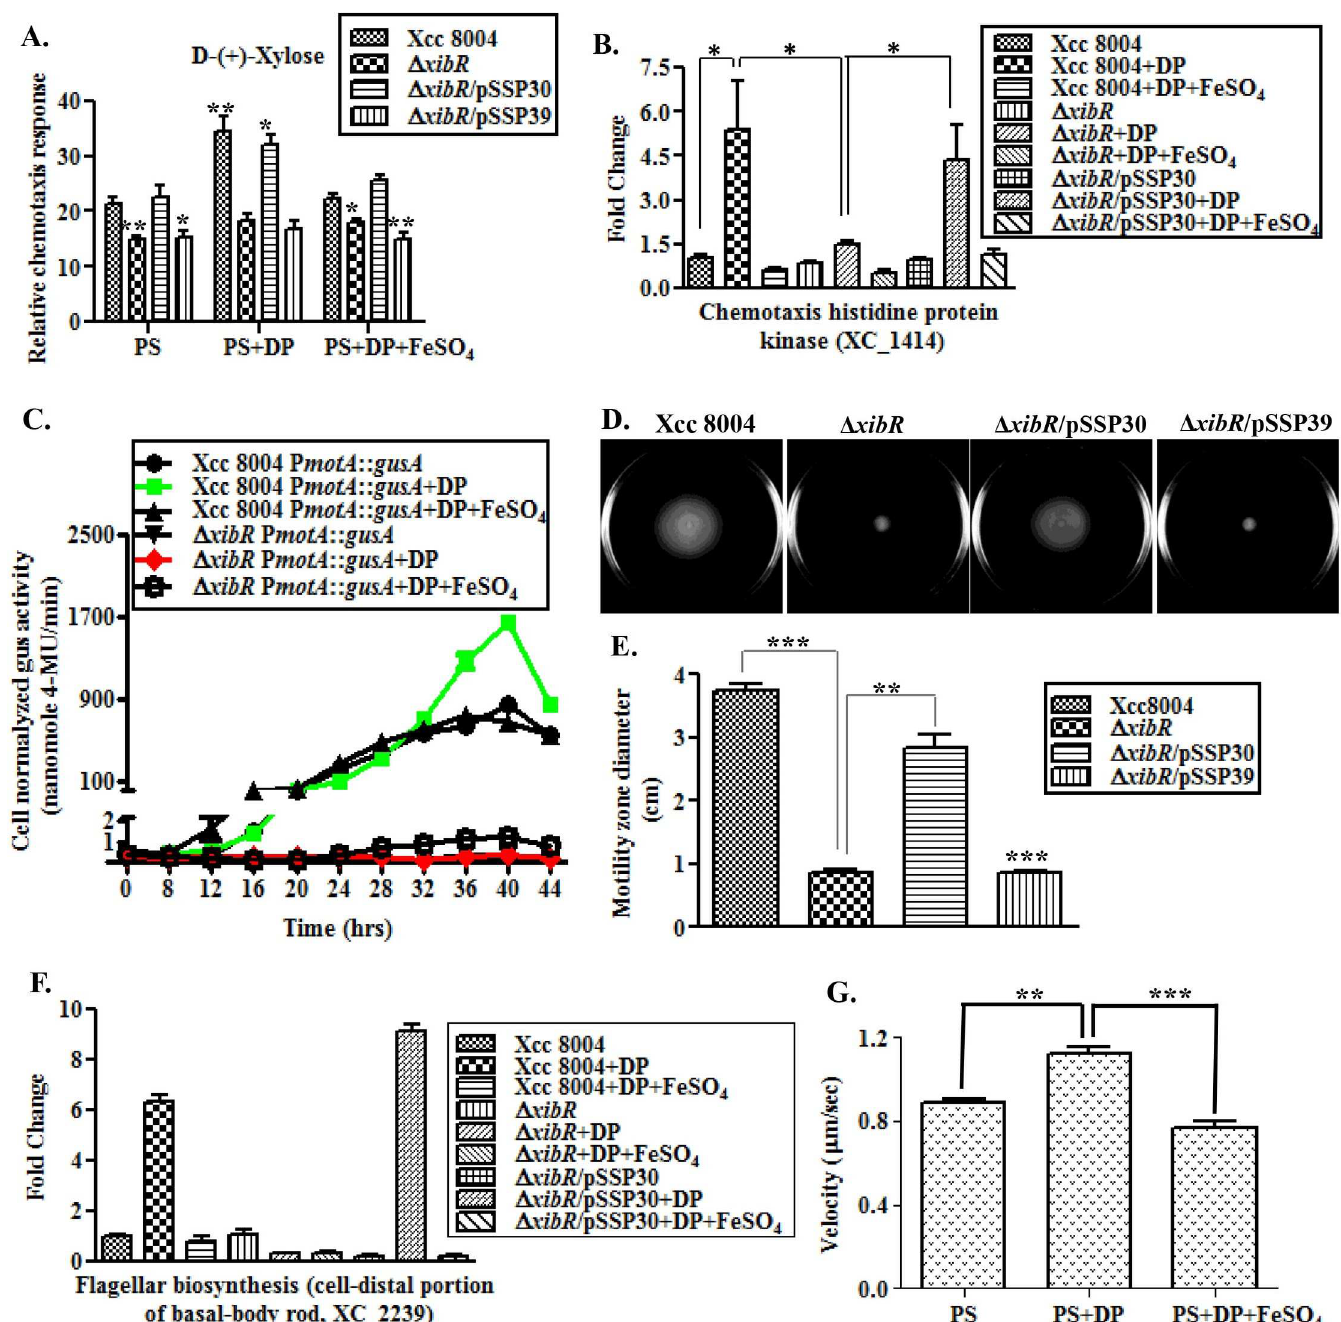
Fig 5. Chemotaxis and motility are regulated by xibR and induced under iron limitation. (A) Quantitative chemotaxiscapillaryassay in responseto D- (+)-Xylose with different Xcc strains grown under PS, PS + 100 μ M DP and PS + 100 μ M DP + 100 μ M FeSO 4 . Cells were incubatedat 28˚C with capillaries containing D-(+)-Xylose (1.2 mM) and PBS. Relativechemotaxisresponse was determined by migratedbacterialcells in capillarycontaining D-(+)-Xylose over the migrated bacterial cells in capillarycontaining PBS. Data are shown as mean ± S.E. (n = 3). The experiment was repeatedtwo times. (B) Relative quantification of the expressionof chemotaxis histidineprotein kinase (cheA3) of Xcc grown under PS, PS + 100 μ M DP, and PS + 100 μ M DP + 100 μ M FeSO 4 by real-time qRT-PCR. 16S ribosomal RNA was used as an endogenouscontrol to normalizethe RNA for cellularabundance. (C) Expression analysisof motA operonin wild-typeXcc 8004and Δ xibR mutant grown under PS, PS + 100 μ M DP, and PS + 100 μ M DP + 100 μ M FeSO 4 by monitoring the β -glucuronidase(GUS) activity. (D) Swim plate motility assay for different Xcc strains; Xcc 8004, Δ xibR , Δ xibR /pSSP30 and Δ xibR /pSSP39. (E) Motility zone diameter quantification from semisolid swim plate motility assay. (F) Relativequantification of the expressionof flagellarbiosynthesisgene for a cell- distal portion of basal-bodyrod (XC_2239) of Xcc grown under PS, PS + 100 μ M DP, and PS + 100 μ M DP + 100 μ M FeSO 4 by real-time qRT-PCR.